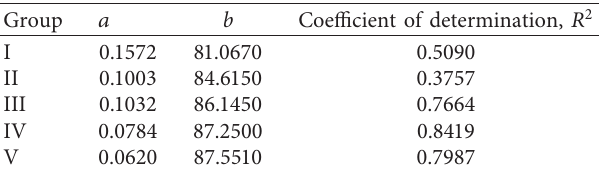
Table 12: Mean of traffic flow on Route O-A-B-D and total travel time in each group of